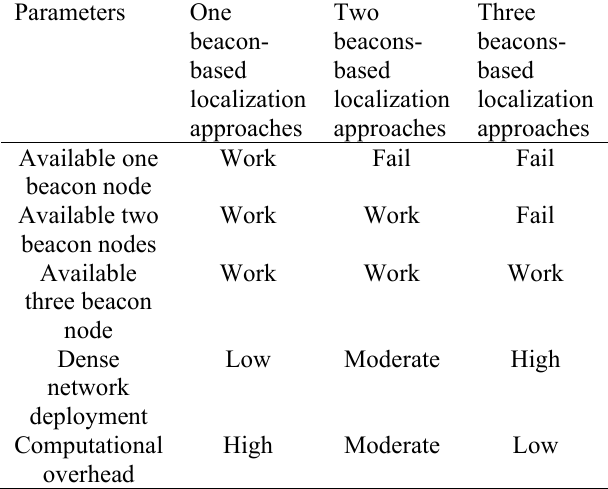
Table 1. Taxonomy of existing well-known beacon- based localization approaches for sensor nodes